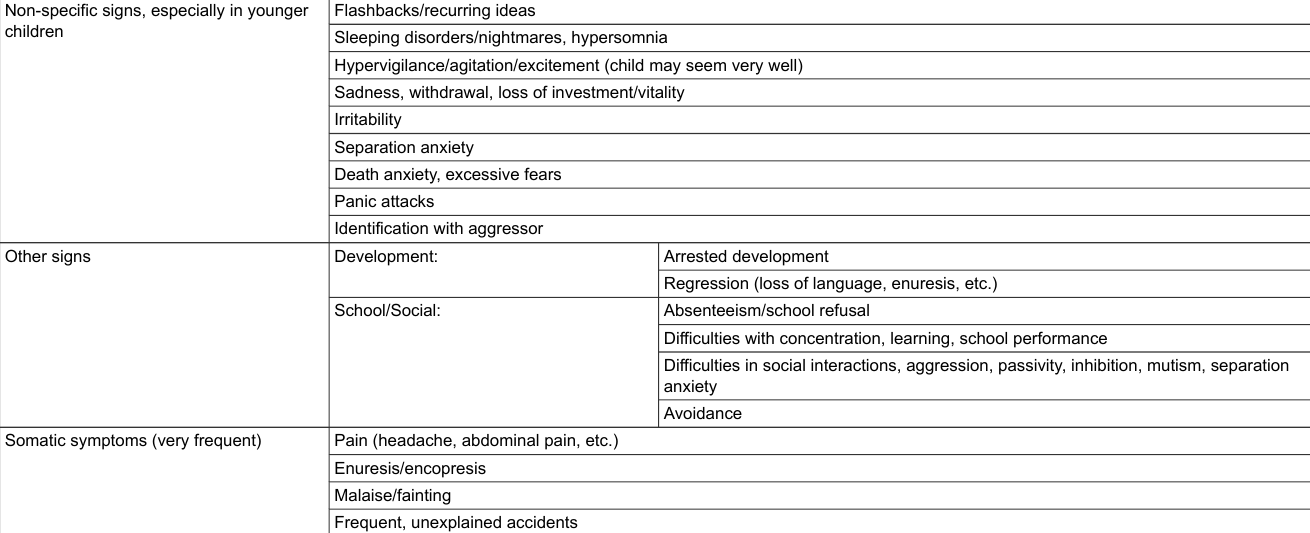
Table 4: Signs of psychological distress. Non-specific signs, especially in younger children